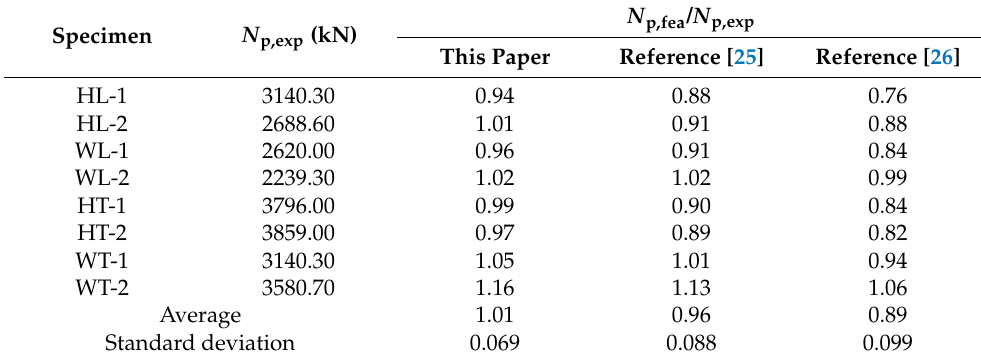
Table 3. Peak carrying capacity comparison between test results and FEA results.